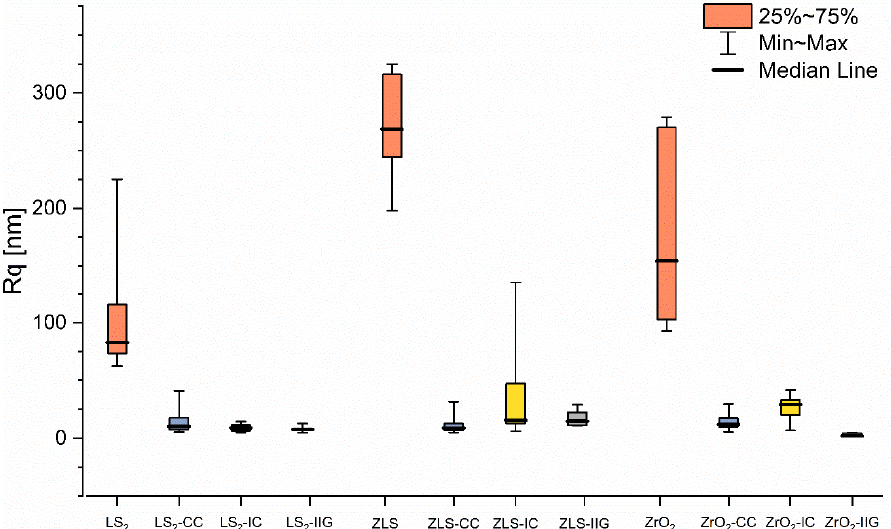
Figure 2. The root-mean-square average roughness (Rq) data for 20 µ m × 20 µ m area of the tested ceramic surfaces before and after glazing.